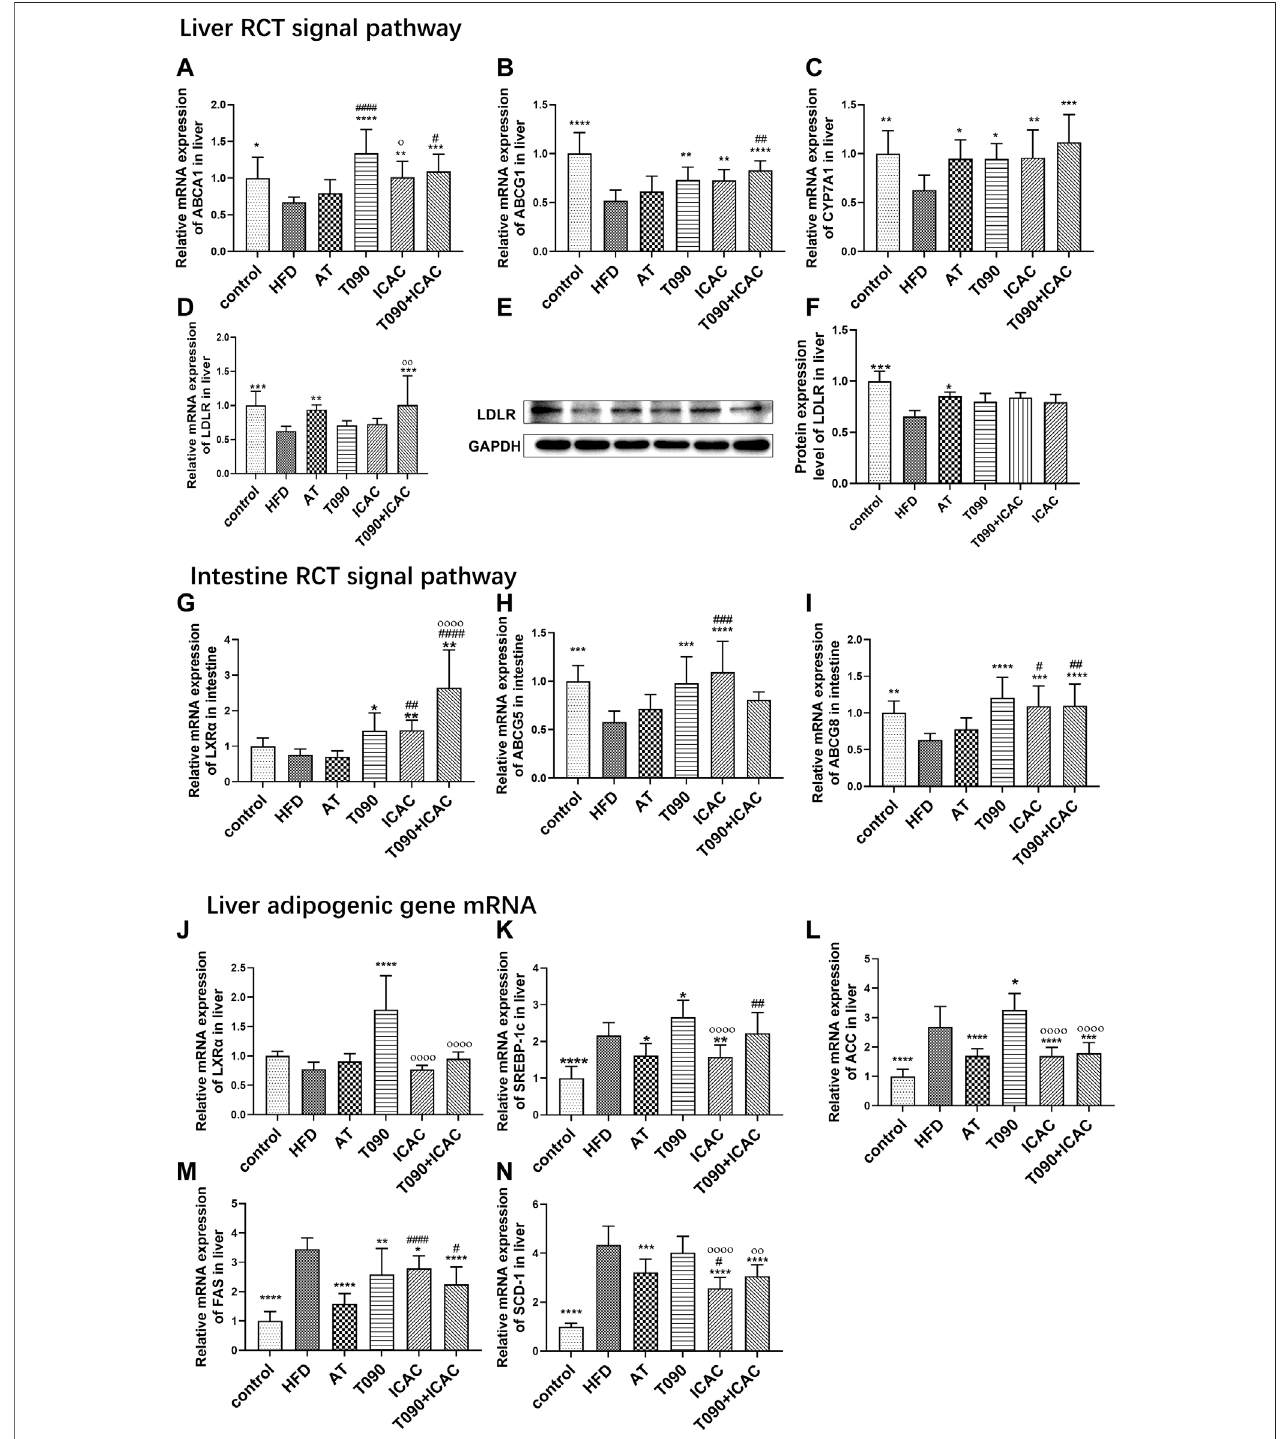
FIGURE 5 | ICAC upregulates liver and intestine RCT pathways without inducing lipogenesis gene expression. (A – C) Gene expression levels of ABCA1, ABCG1, andCYP7A1,intheliverofmice. (D – F) GeneandproteinexpressionlevelsofLDLRintheliverofmice. (G – I) GeneexpressionslevelsofLXR α ,ABCG5,andABCG8inthe intestine of mice. (J – N) Gene expression levels of LXR α , SREBP-1c, ACC, FAS, and SCD-1 in the liver of mice. All data were represented mean ± SEM. Statistical difference was determined by one-way ANOVA test. Comparedwith HFD, * p < 0.05, ** p < 0.01, *** p < 0.001,**** p < 0.0001. ComparedwithAT, # p < 0.05, ## p < 0.01. Compared with T090, o p < 0.05, oooo p < 0.0001. n = 10 for each group.